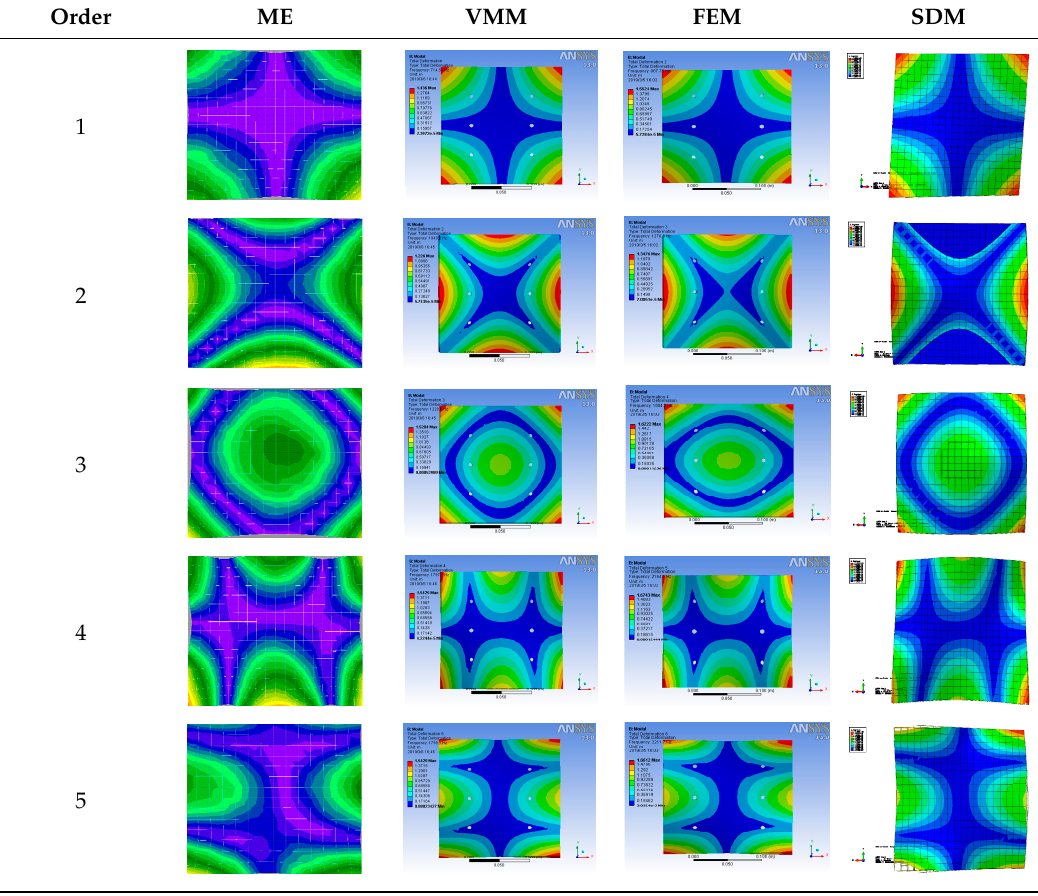
Table 2. Comparison of the first five mode shapes obtained by the simulation and modal experiment.